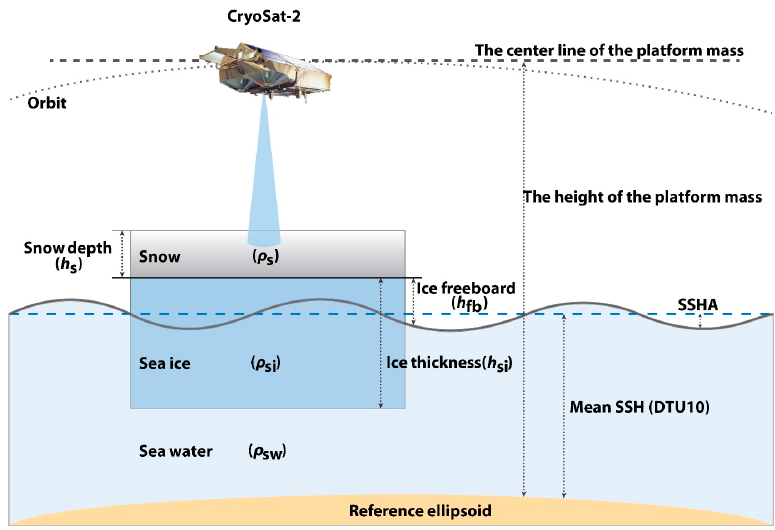
Figure 1. Schematic diagram of the freeboard and thickness processing from CryoSat-2. SSHA, Sea Surface Height Anomaly.